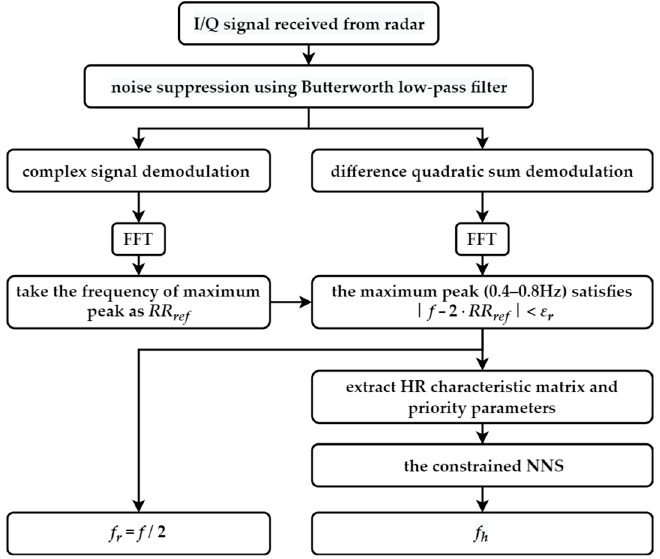
Figure 2. The flowchart of the whole algorithm process to extract HR and RR.